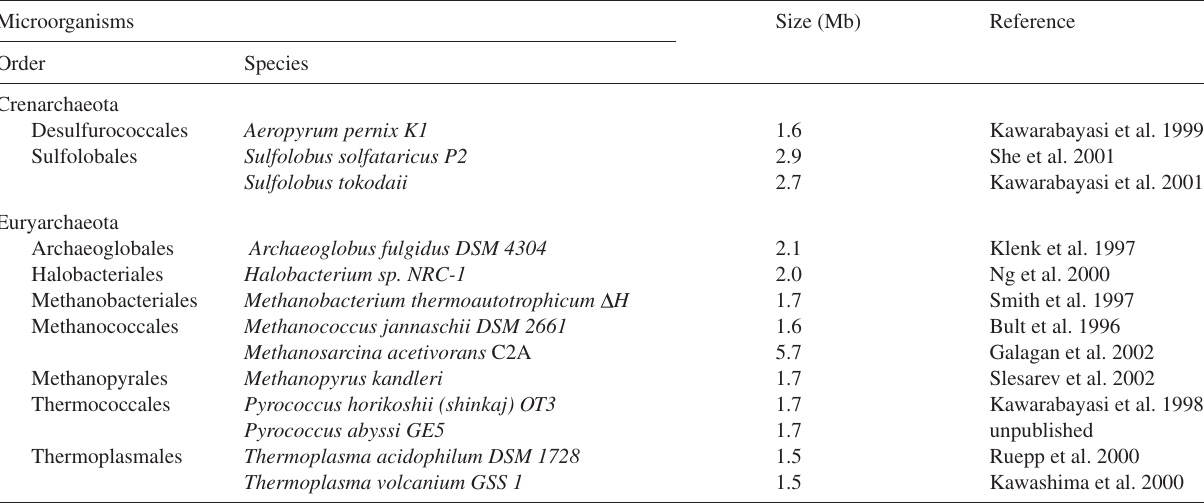
Table 1. List of completed genome sequences (sources: The Institute for Genomic Research (TIGR, Rockville, MD) and PUBMED).